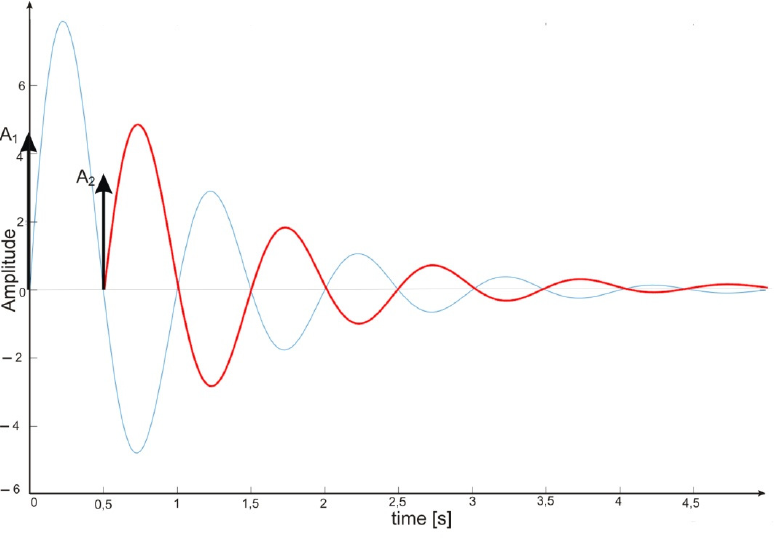
Figure 3. The principle of vibration elimination. The impulse response of the object to impulses A1 and A2.